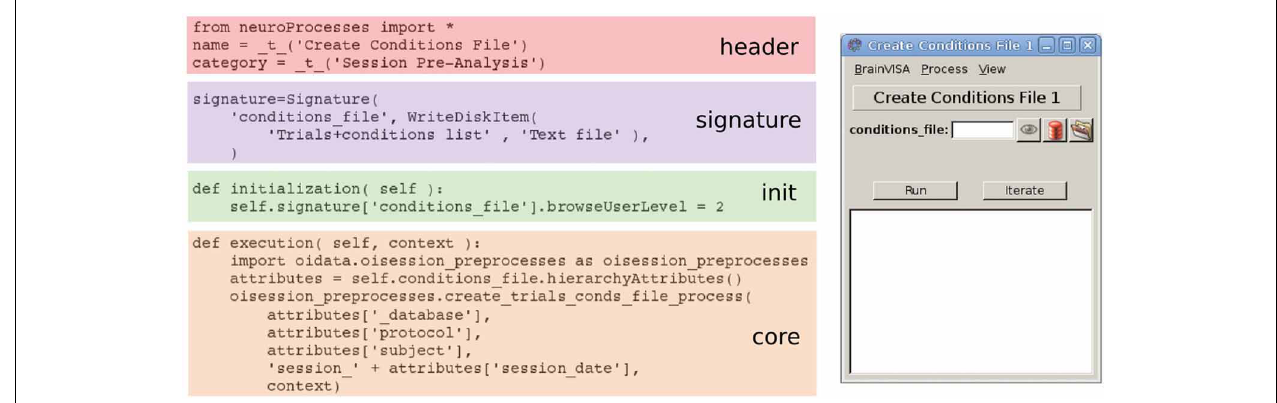
FIGURE 1 | Illustration of the use the BrainVISA API with one of the processes defined in Vobi One . The source code (from which comments have been removed for space purposes) follows a simple formatting with four sections. It produces the GUI displayed on the right. Note that the core section only contains a call to a single function, which is a generic coding principle we adopted in Vobi One